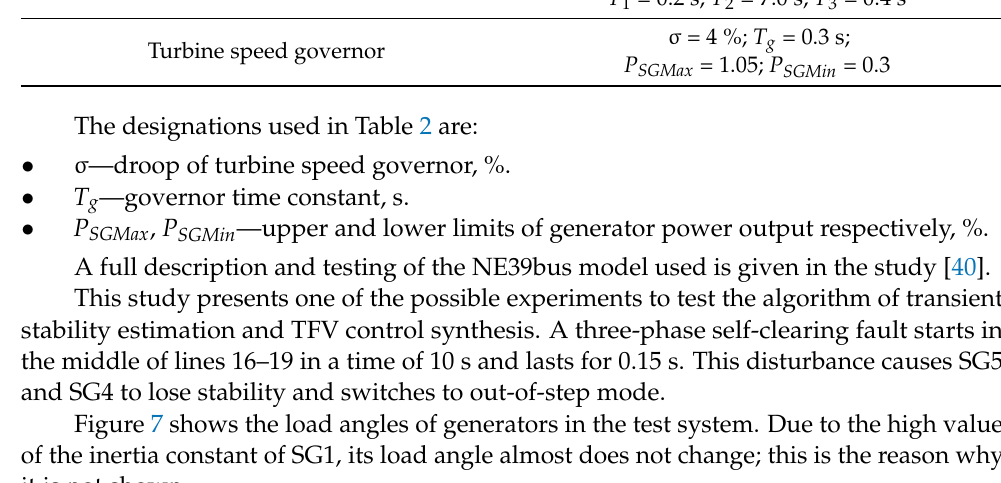
Table 2. Parameters of steam turbine and speed Table 1. Initial states of generators.